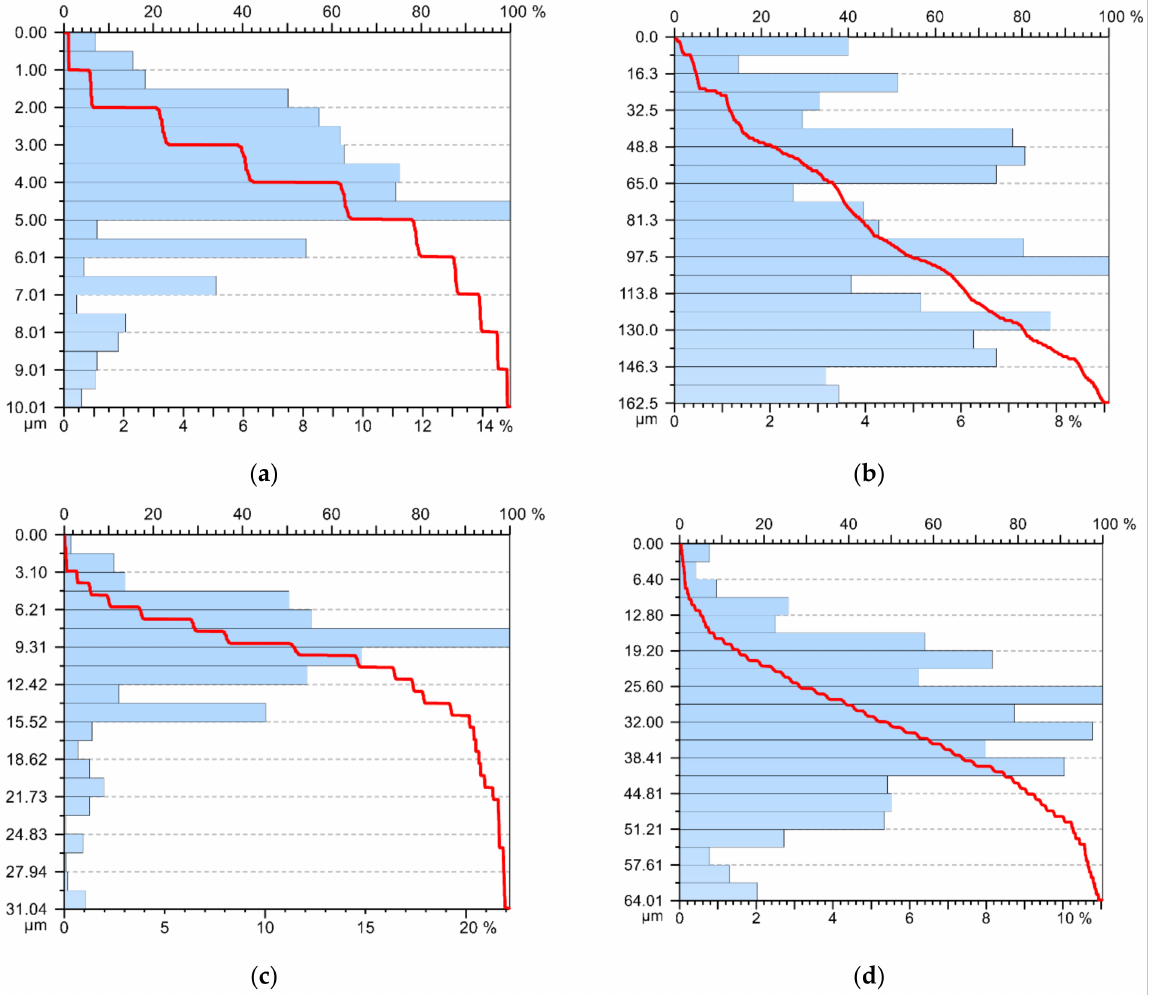
Figure 12. Abbott–Firestone curve: ( a ) in case of machining with the cutting tool T01 to the outside; ( b ) in case of machining with a T01 cutting tool inwards; ( c ) in case of machining with a T02 cutting tool to the outside; ( d ) in the case of machining with a T02 cutting tool